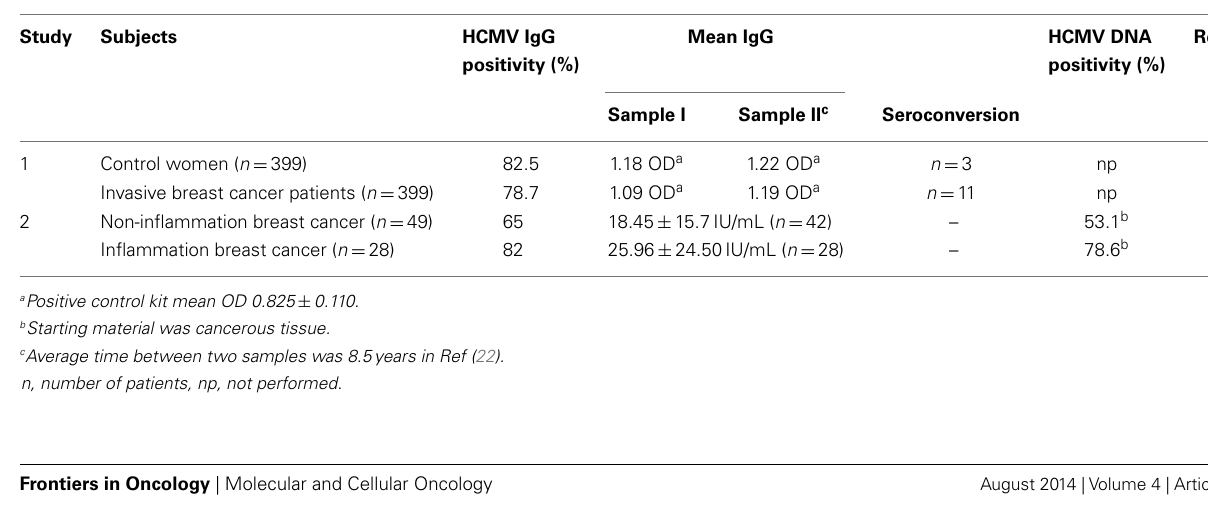
Table 2 | HCMV prevalence in breast cancer patients